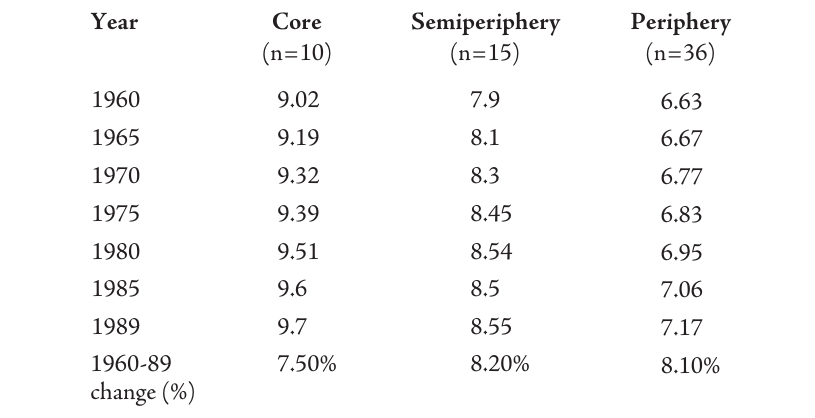
Table 6 – Mean logged GDP per capita for three zones of the world-economy (PWT data; weighted